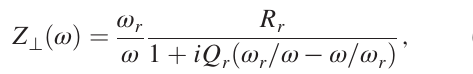
FIG. 12. NHT result for the growth rate Im q (cid:3) ¼ ð ω gain g and intensity parameter ImpF ¼ N=N 0 for reactive damper and zero chromaticity. Gain is in units of ω sign corresponds to focusing.